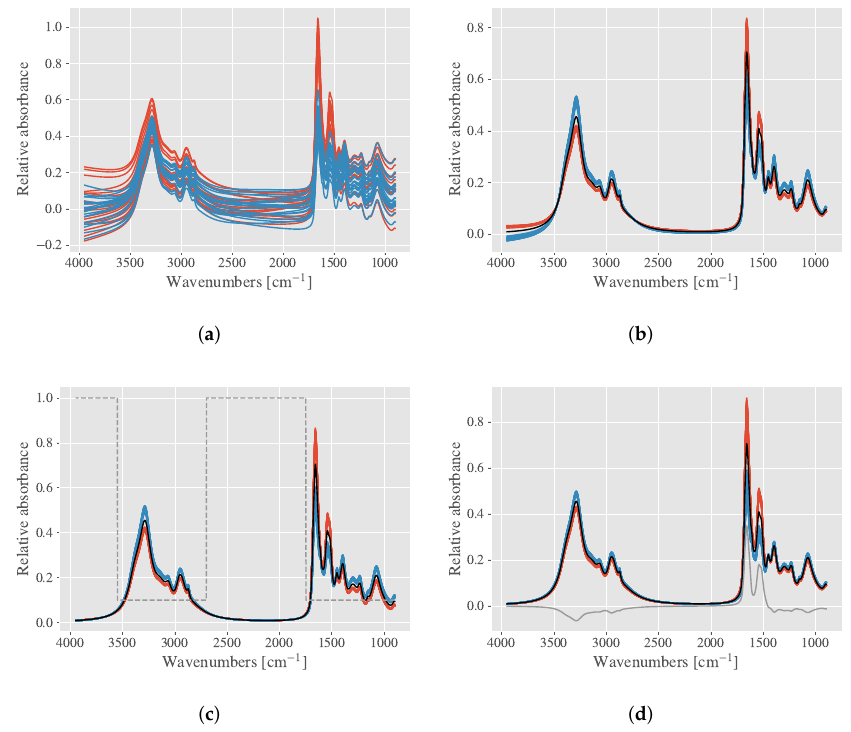
Figure 3. Using EMSC models on a simulated dataset consisting of two chemically different groups. ( a ) Simulated spectra, physical effects are added to the simulated pure absorbance spectra. Spectra corrected by ( b ) EMSC with polynomials up to the 2nd degree; ( c ) EMSC with weights, shown in dashed gray; ( d ) EMSC with an analyte constituent spectrum, shown in